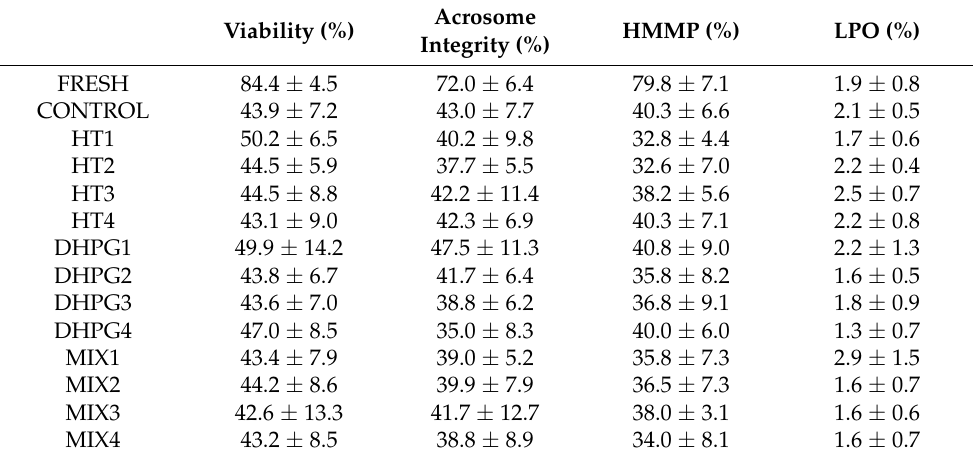
Table 1. Descriptive statistics of sperm viability, acrosome integrity, HMMP, and LPO parameters in fresh and frozen-thawed buck sperm. Data are expressed as Mean ±